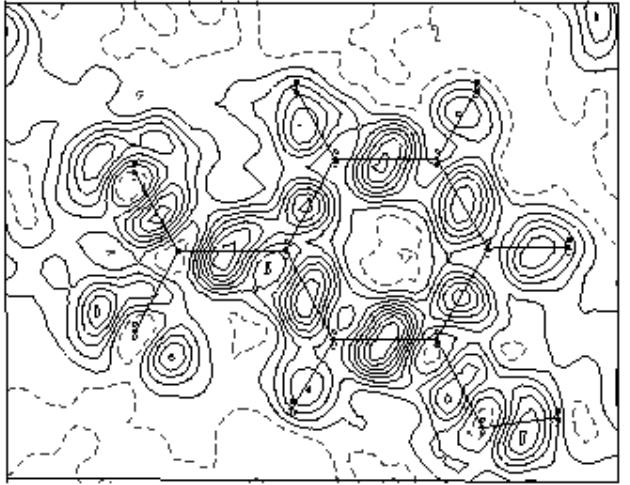
rrr -= r is the observed . spho exp o